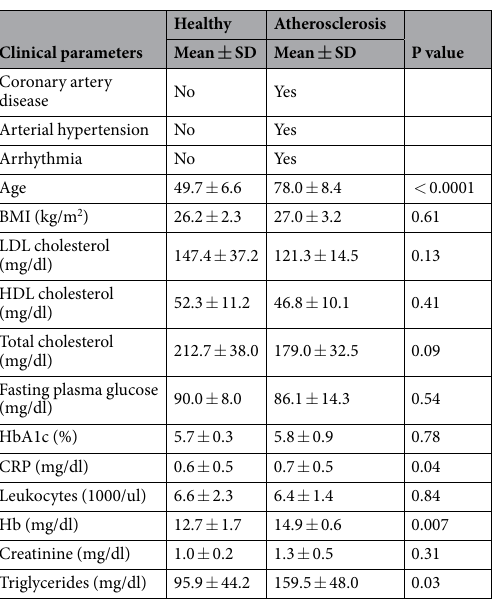
Table 1. Volunteer characteristics. Statistical analysis performed by means of the student T